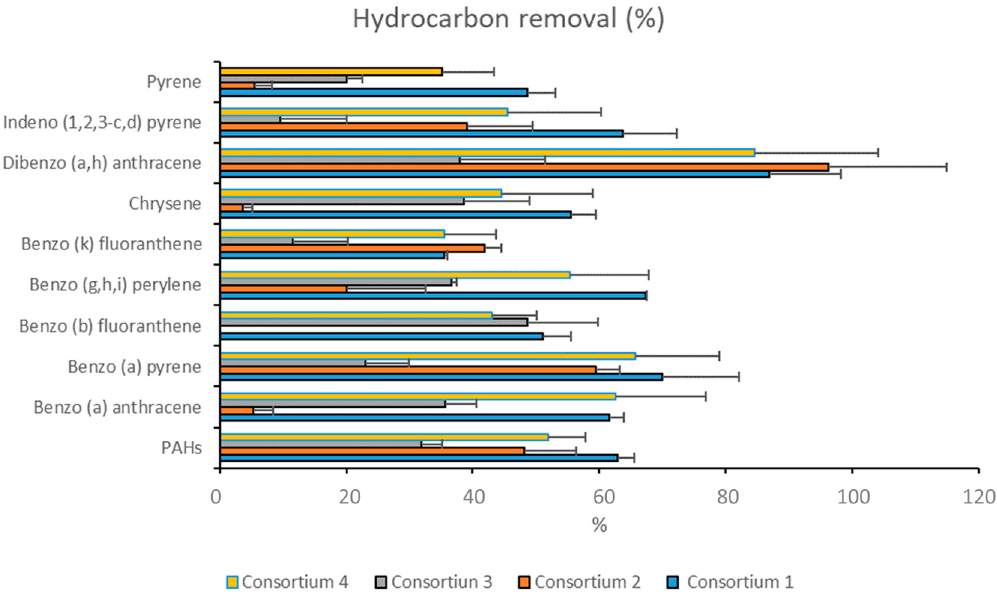
Figure 3. Hydrocarbon removal rates (%) after 27 days of incubation of polluted sediments with the four consortia (see Table 1 for bacterial composition).